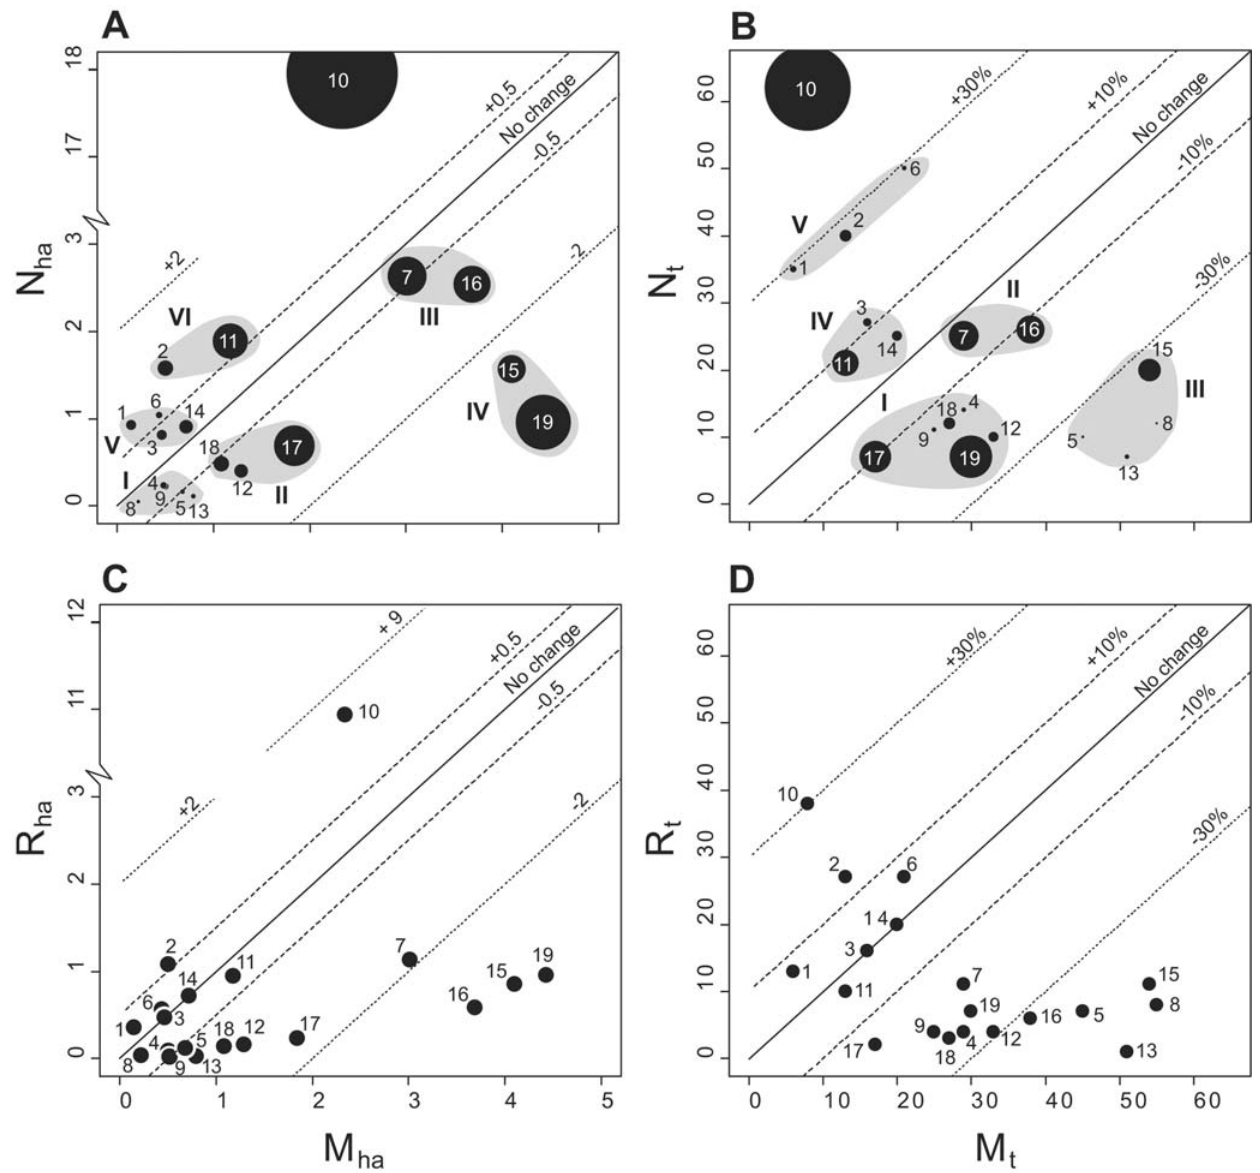
Figure 6. Trend of change for sites. Change, i.e. difference between mortality and recruitment, is the orthogonal distance from the diagonal axis. Labels are explained in Table 1. A and C show absolute change and B and D relative change. In A and B sizes of symbols are proportional to total vegetation density and recruitment estimates are based on new indivduals. Grey shapes show clusters of sites with similar types of change, resulting from similar combinations of mortality and recruitment: A I–III: low to intermediate negative, IV: high negative, V–VI: low to intermediate positive, B I– II: low to intermediate negative, III high negative, IV low positive and V high positive. In C and D recruitment estimates are based on recruits . Note the discontinuous scale on the y-axis in A and C